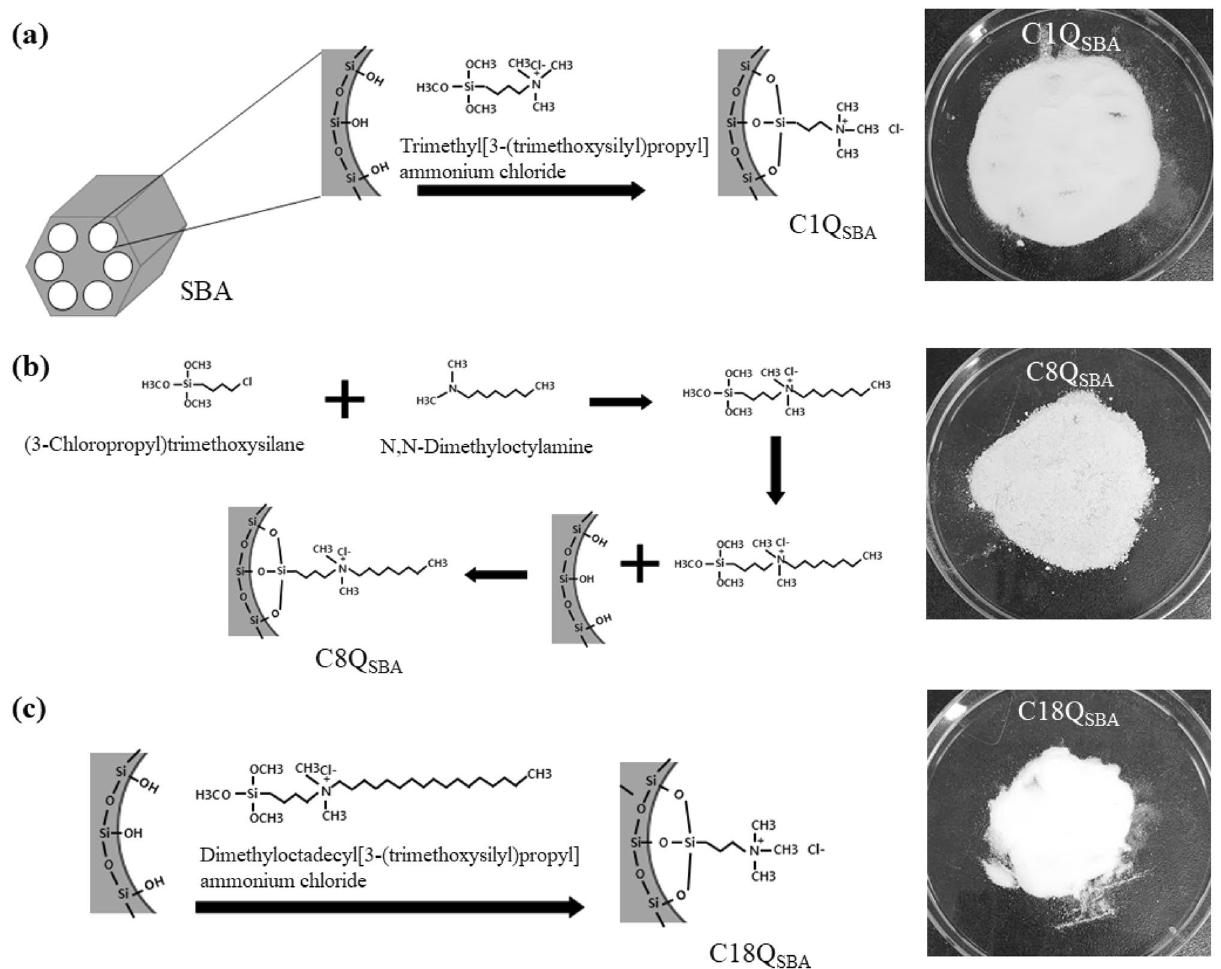
Figure 1. Schematics of the procedures for preparing Q SBA samples and their digital images: ( a ) C1Q SBA , ( b ) C8Q SBA , and ( c ) C18Q SBA . Figure was modified from Kang and Kim 35 .